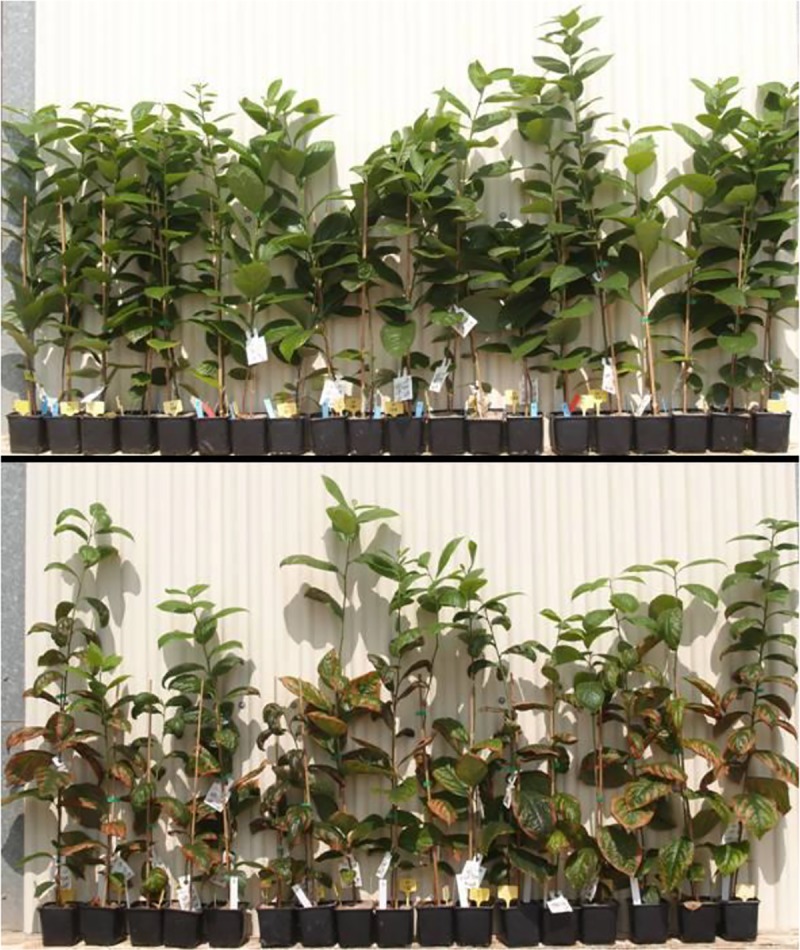
Phenotype of the saline tolerant (up) and sensitive (down) backcross population (BC) plants after 72 days of irrigation with 40mM NaCl.